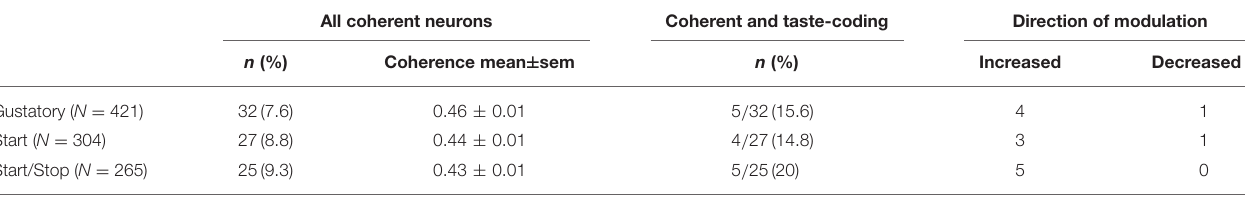
TABLE 3 | Coherent neurons in the NAcSh that convey information about sucrose-concentration. All coherent neurons Coherent and